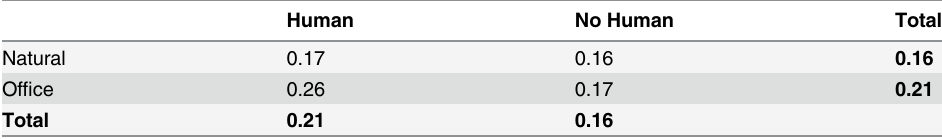
Table 1. The proportion of participants who responded yes to the question, “ Would you consider getting this animal as a pet? ” when presented with photographs showing a primate pictured with or without a human in a natural or of fi ce